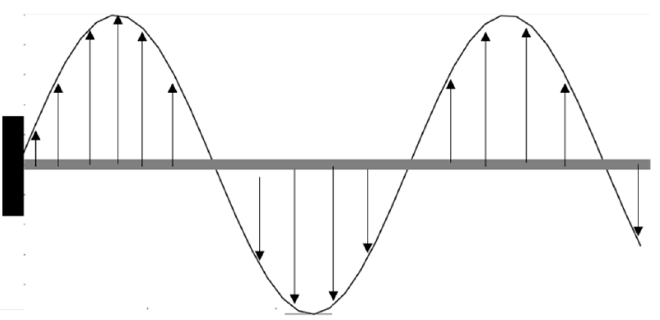
Figure 3. Numerical model of the beam and spatial load distribution for training the ML